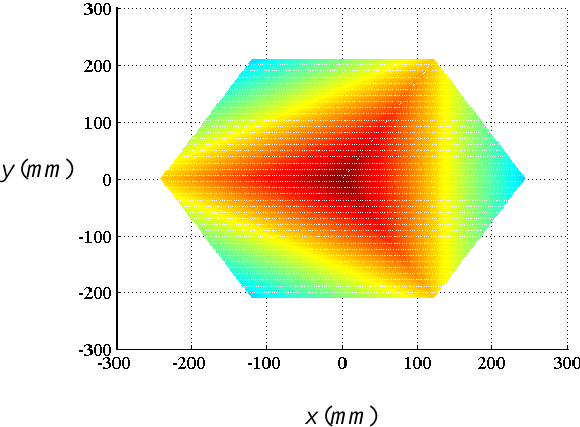
Figure 13. x – y section of the workspace at α = 35 ◦